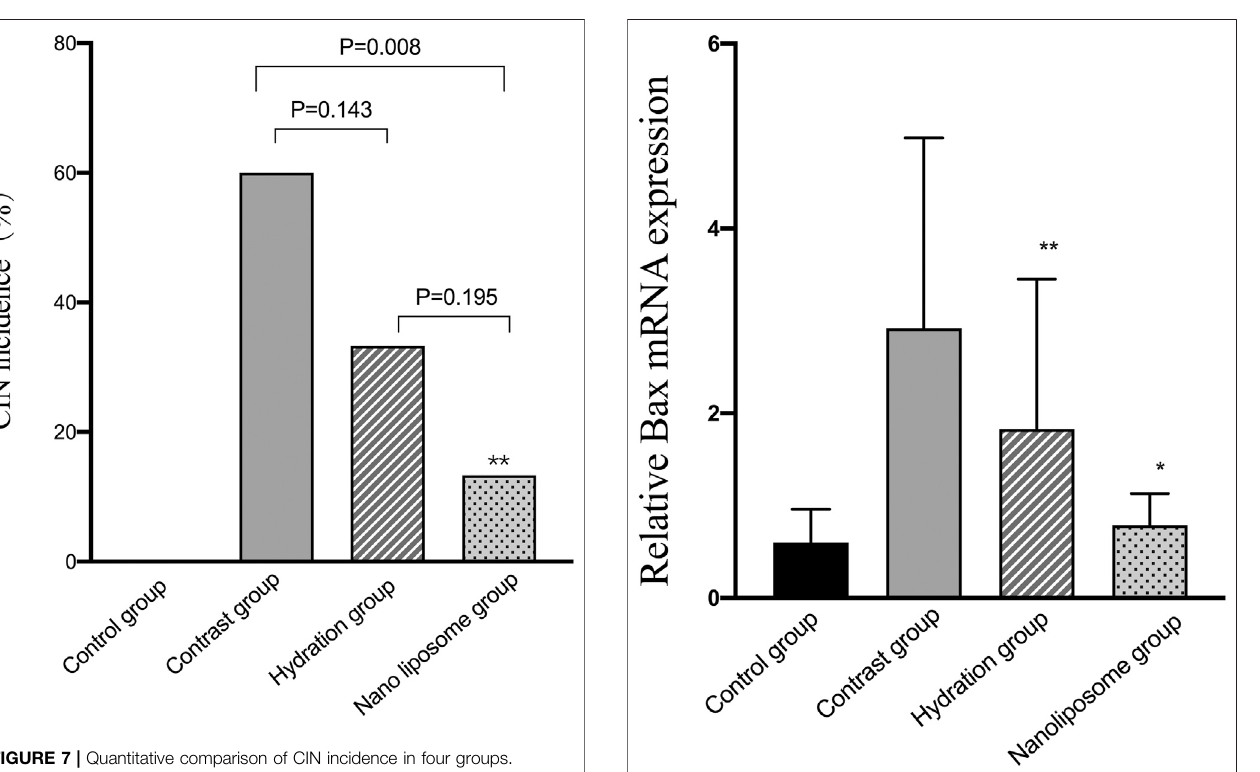
FIGURE 8 | The relative mRNA expression of target gene was detected by Real-time PCR. Real-time PCR was used to validate the change in the expression of the Bax gene identi fi ed in four groups. Bax: Bcl-2 subfamily, pro-apoptotic factor. Values are expressed as mean ± SD. *Compared with the contrast group, p < 0.05. **Compared with the contrast group, p < 0.01. # Compared with the hydration group, p < 0.05. ## Compared with the hydration group, p <